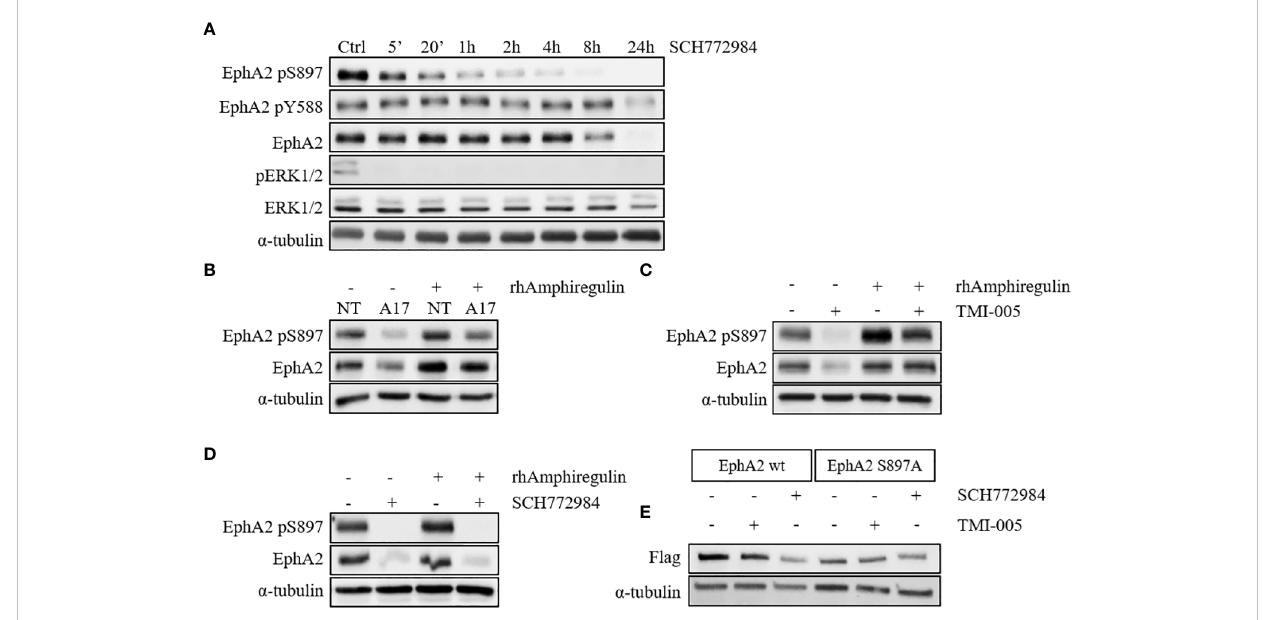
FIGURE 3 ADAM17 and IR regulate EphA2 S897 phosphorylation via the MAPK pathway. (A) ERK1/2 inhibition with SCH772984 (500nM) abrogates EphA2 S897 phosphorylation followed by a reduction of the total EphA2 levels. Concurrent rhAmphiregulin (50ng/ml) treatment in (B) shADAM17 and (C) TMI-005- treated cells rescues EphA2 protein levels, while EphA2 in (D) SCH772984-treated cells was not rescued. In all experiments, cells were treated with rhAmphiregulin/TMI-005/SCH772984 for 24h. (E) ADAM17 inhibition with TMI-005 reduced fl ag-tagged EphA2 wt but not the mutated form (S897A). For all immunoblotting experiments, a -tubulin was used as the housekeeping control. The fi gures are representatives of two independent